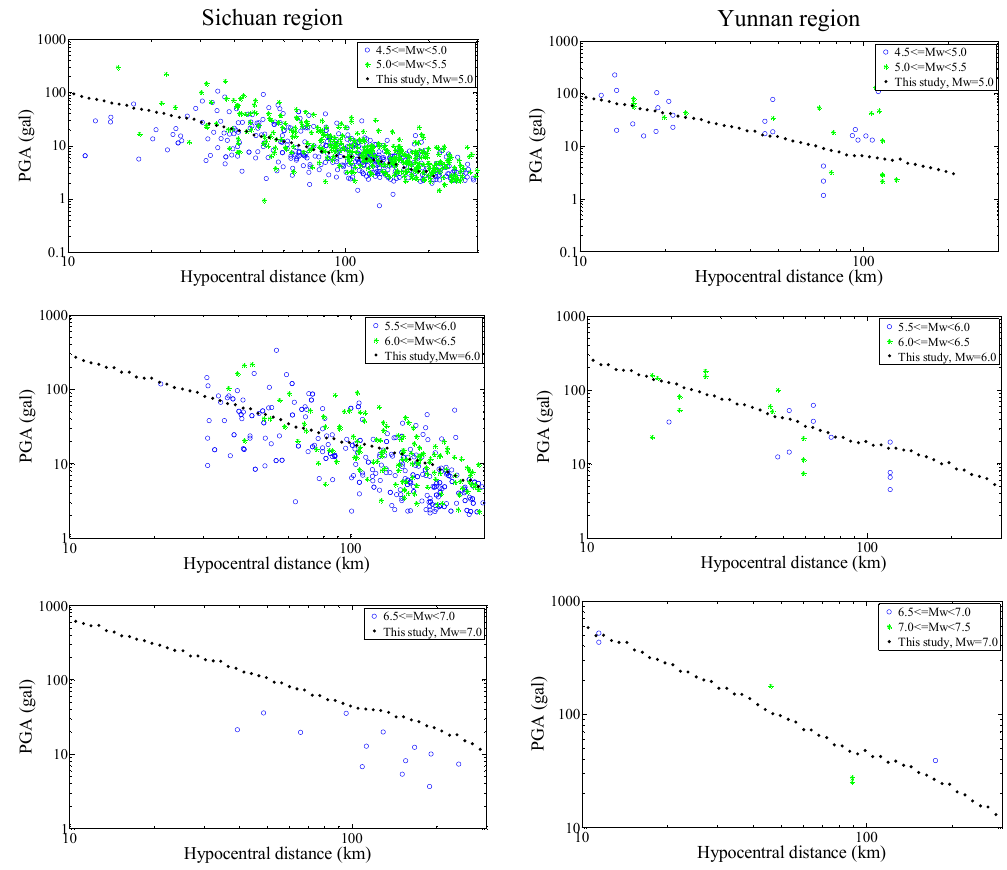
Figure 6. Comparison of the result with strong ground motion data in the Sichuan region and the Yunnan